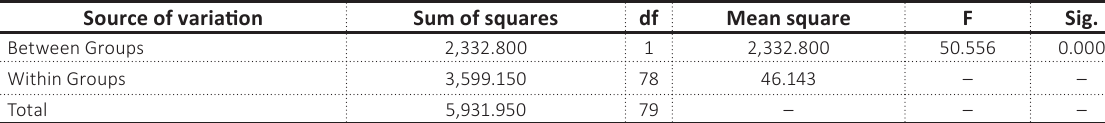
Table 8. ANOVA results for assessing the fraud risk management team